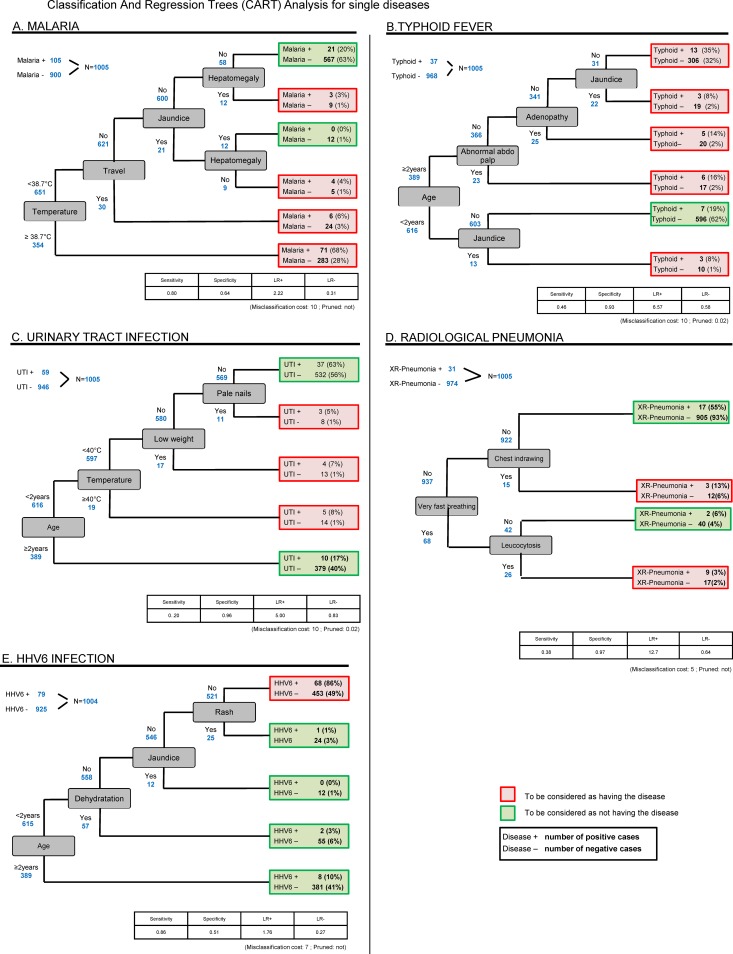
CART analyses for single diseases.Classification and regression trees analyses for single diseases. A. Malaria; B. Typhoid fever; C.Urinary tract infection; D. Radiological pneumonia; E.Human Herpes Virus 6 (HHV6) infection.